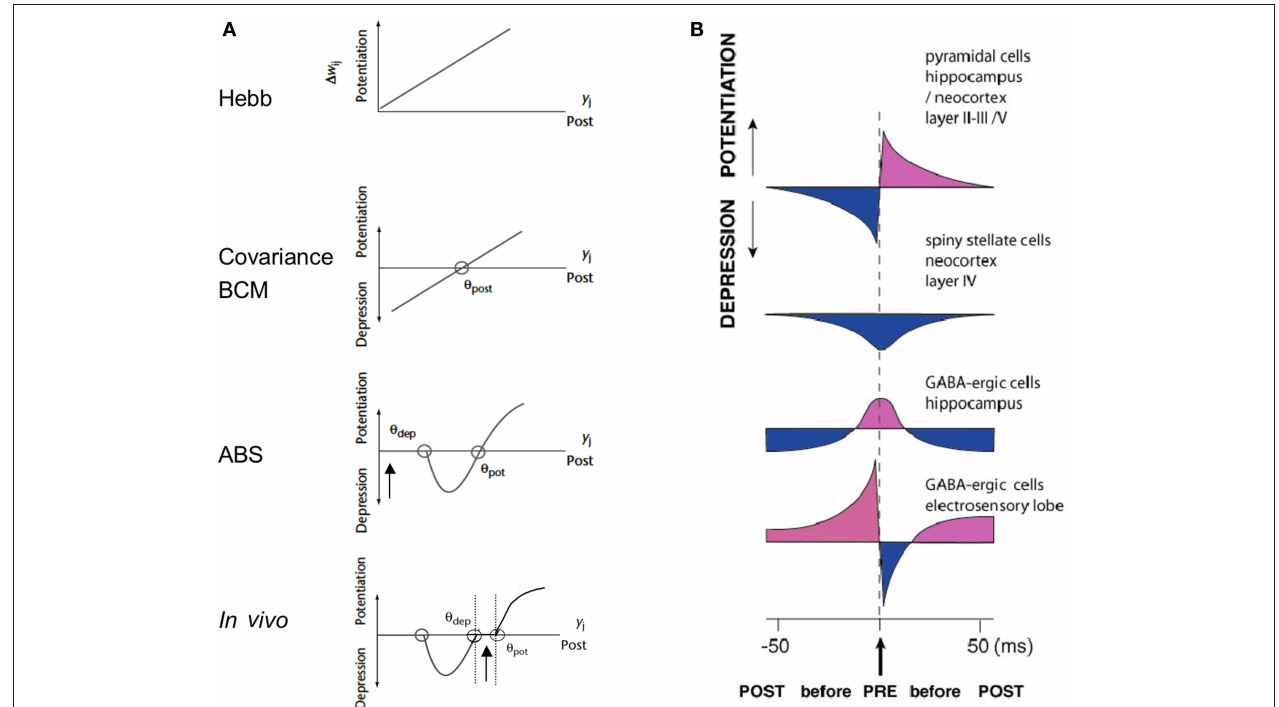
Figure 10 | For a diversity of plasticity rules in vitro and in vivo . (A) Generalized Hebbian forms of plasticity. From top to bottom, Hebb’s rule (top) and the most often observed rules of homosynaptic plasticity established in vitro and in vivo (bottom). Each graph expresses the theoretical relationship between the induced synaptic change (positive ordinates for potentiation, negative for depression) and postsynaptic activity at the time of the association. The slope is proportional to presynaptic activity. The simple Hebbian rule predicts potentiation only. The covariance rule (second from the top) and A-B-S rule (third from the top) predict both depression and potentiation with, respectively,